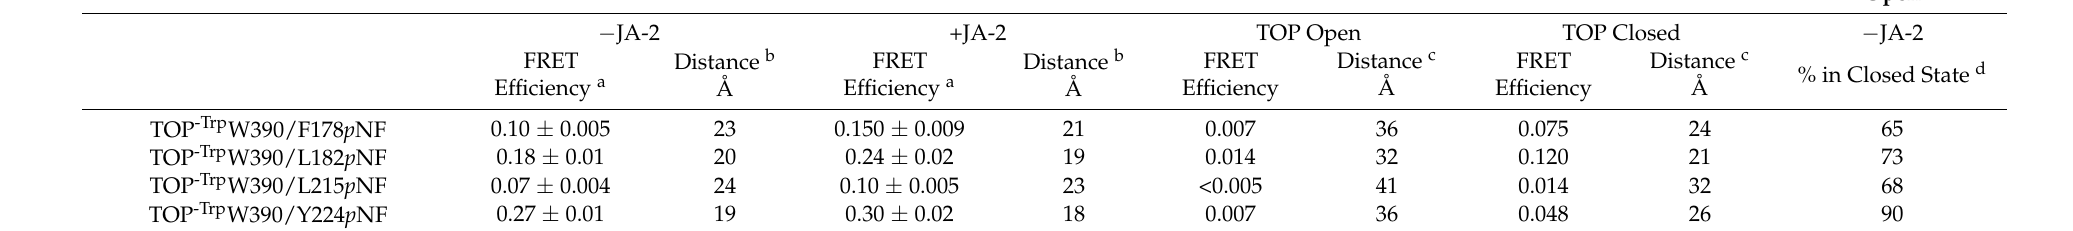
of DTT. b D-A distances are calculated using Equation (1). c Distance between C β of donor and C β of acceptor. d In the absence of JA-2 using the 2 state model as discussed in the